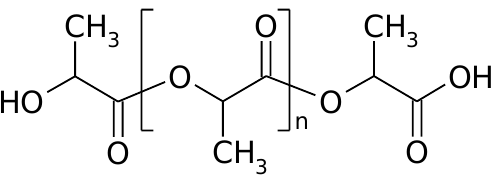
Figure 4. The fragment of polylactide